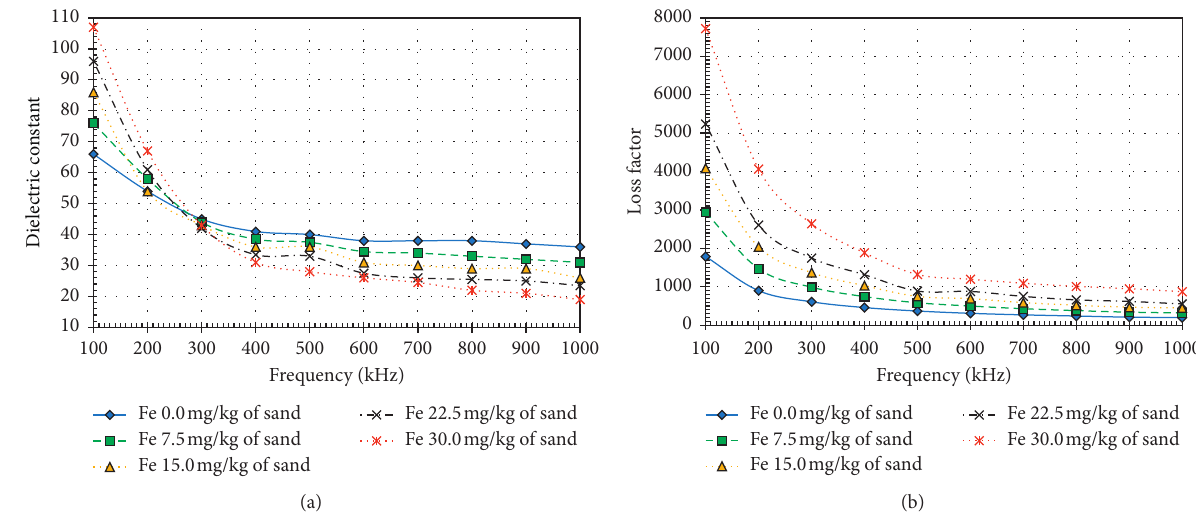
Figure 5: Complex permittivity of sand contaminated with Fe. (a) Dielectric constant versus frequency. (b) Loss factor versus frequency.